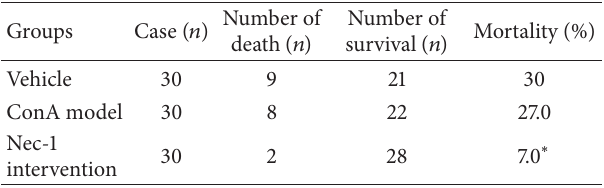
Table 3: Influence of the Nec-1 intervention on mortality caused by ConA-induced liver injury.